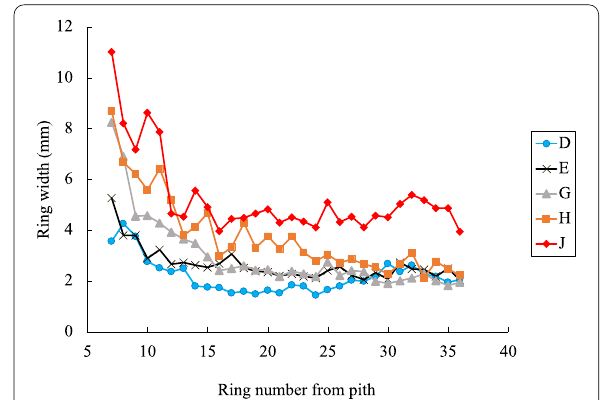
Fig. 3 Effects of initial tree density on ring width. Each plot shows an average value in a ring number among sample trees of each tree density zoning symbol. Number of sample trees of each initial tree density zoning symbol range from five to nine. Initial tree density zoning symbols were the same, as shown in Table